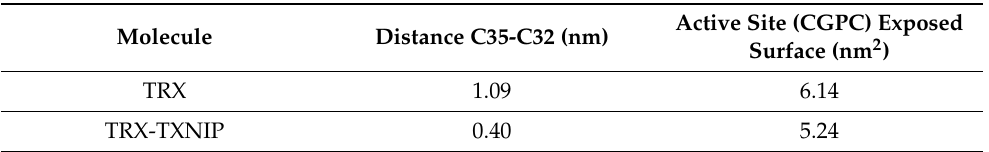
Table 2. Mean distances along the MD trajectory between Cys 35 and Cys 32, and mean solvent accessible surface of the active site (CGPC), in absence or in presence of TXNIP.